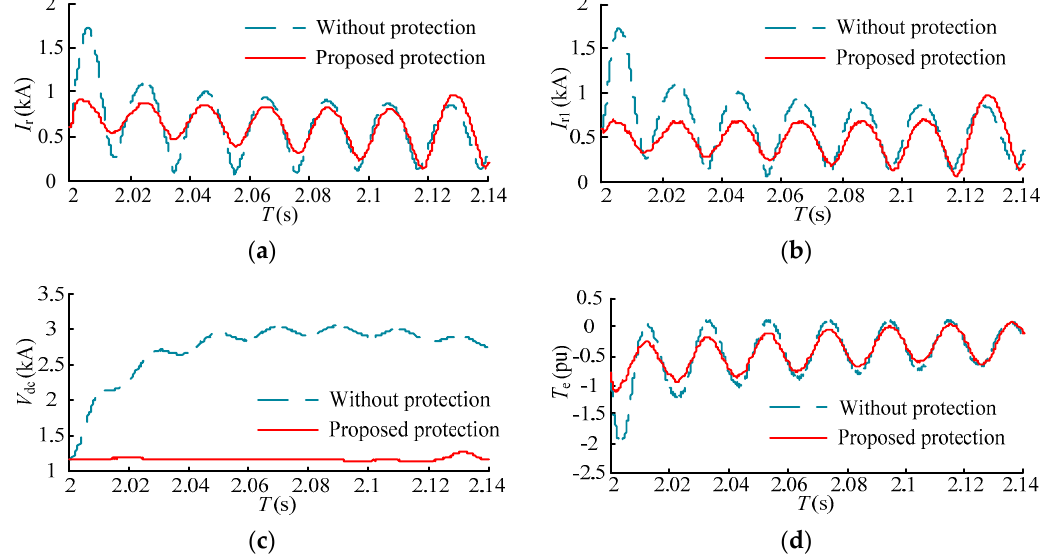
Figure 15. Response of proposed protection under a voltage sag of 0.8. ( a ) Rotor current; ( b ) RSC current ( c ) DC-link bus voltage; and ( d ) electromagnetic torque.